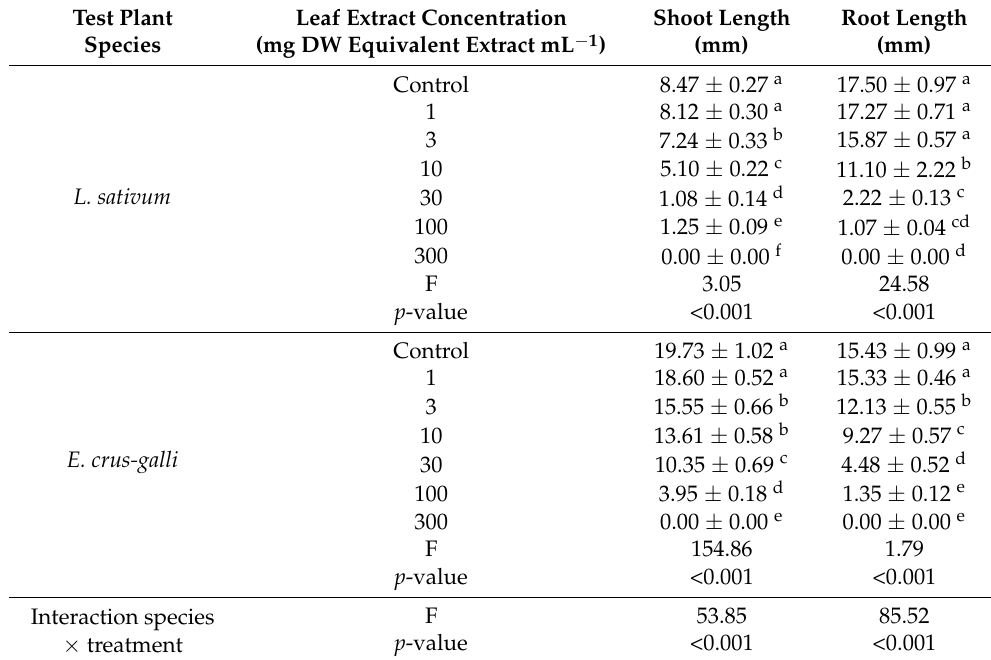
Table 1. Growth inhibitory effects of the aqueous methanol extracts of S. garrettiana leaf against the L. sativum and E. crus-galli seedlings at different concentrations after 48 h of